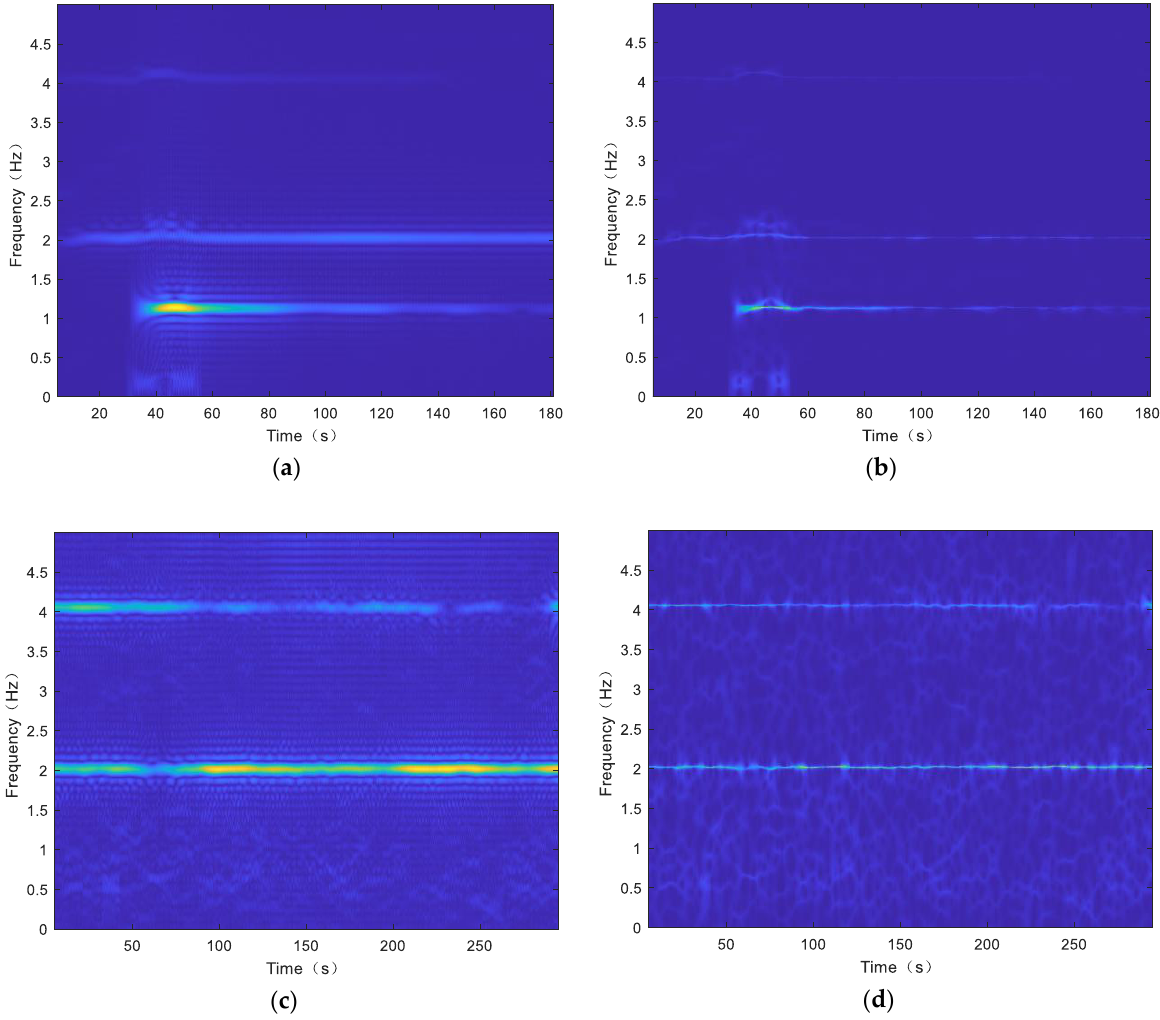
Figure 9. Time-frequency distribution of the shortest cable. ( a ) result of CZT-based short-time Fourier transformation (STFT) and ( b ) result of APES-based time-frequency distribution, when a train passes by for 35 s and 40 s. ( c ) Result of CZT-based STFT and ( d ) result of APES-based time-frequency distribution, when the bridge is on a free condition.